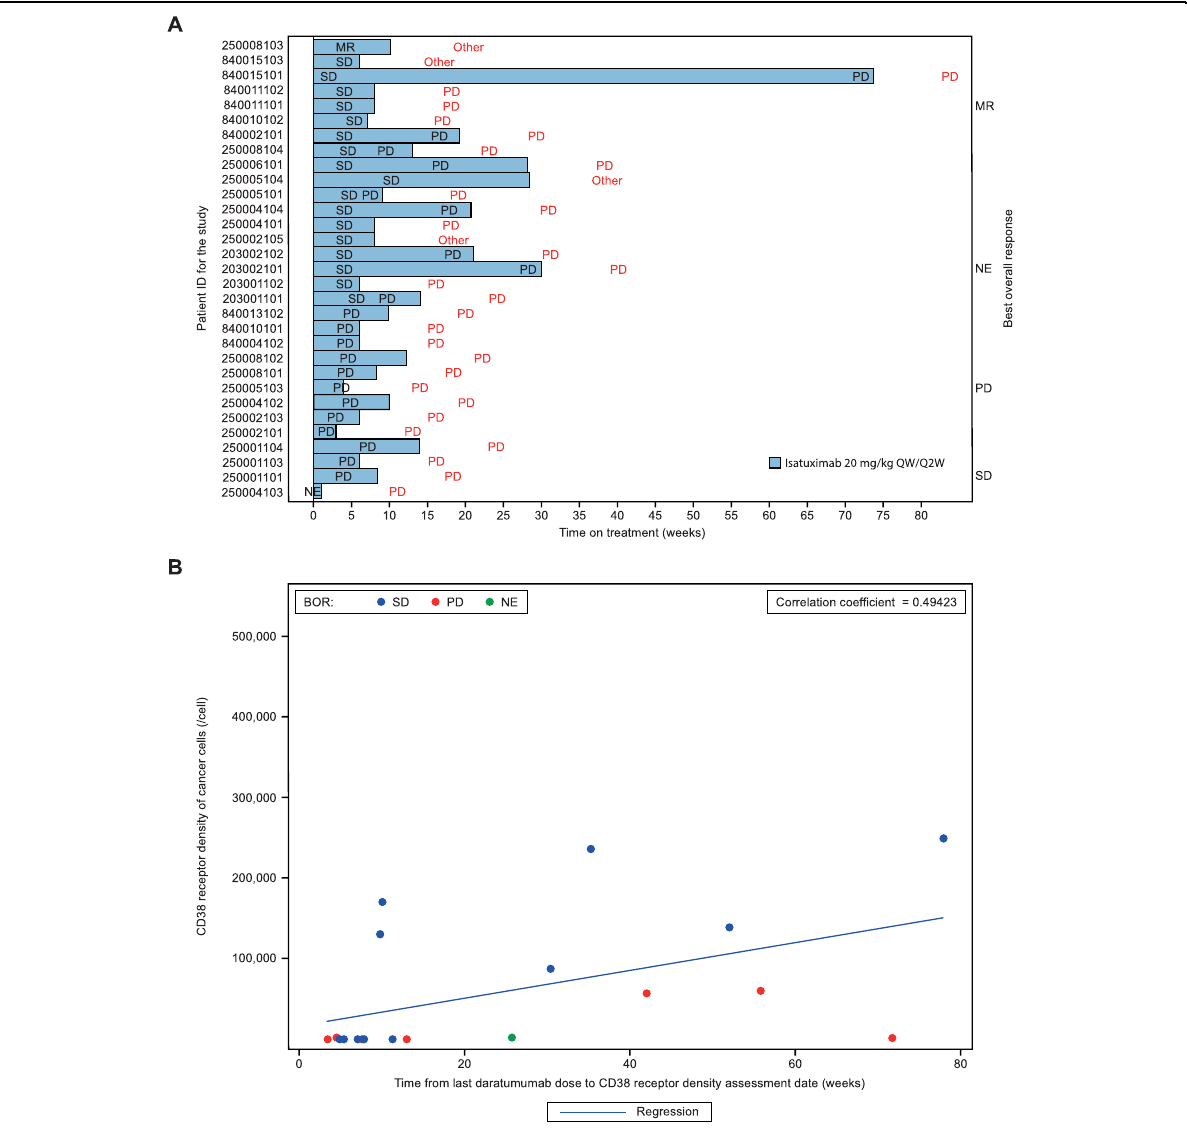
Fig. 1 Isatuximab monotherapy treatment response correlation with CD38 receptor density. A Swimmer plot of time on treatment with isatuximab monotherapy. Each bar represents one of the 31 patients evaluable for response in the study (i.e., patients who completed at least one cycle of treatment and who had at least one disease assessment or patients with clinical progression or patients who died within 30 days of fi rst dose due to disease progression). One out of the 31 patients had no evaluable response. Text in red font corresponds to the reason for treatment discontinuation. B Higher baseline CD38 receptor density was associated with longer periods from the last daratumumab dose to the CD38 receptor density assessment date. The scatter plot shows the CD38 receptor density data and time from last daratumumab dose to CD38 receptor density assessment date (all-treated population). The CD38 receptor density of cancer cells was measured at baseline by quantitative fl ow cytometry in bone marrow aspirate from 19 of 32 patients. The estimated CD38 receptor density re fl ects the number of free receptors per cell accessible for isatuximab binding and not the total CD38 receptor density. BOR best overall response, MR minimal response, NE not evaluable, PD progressive disease, QW/Q2W once weekly for 4 weeks, then every other week, SD stable